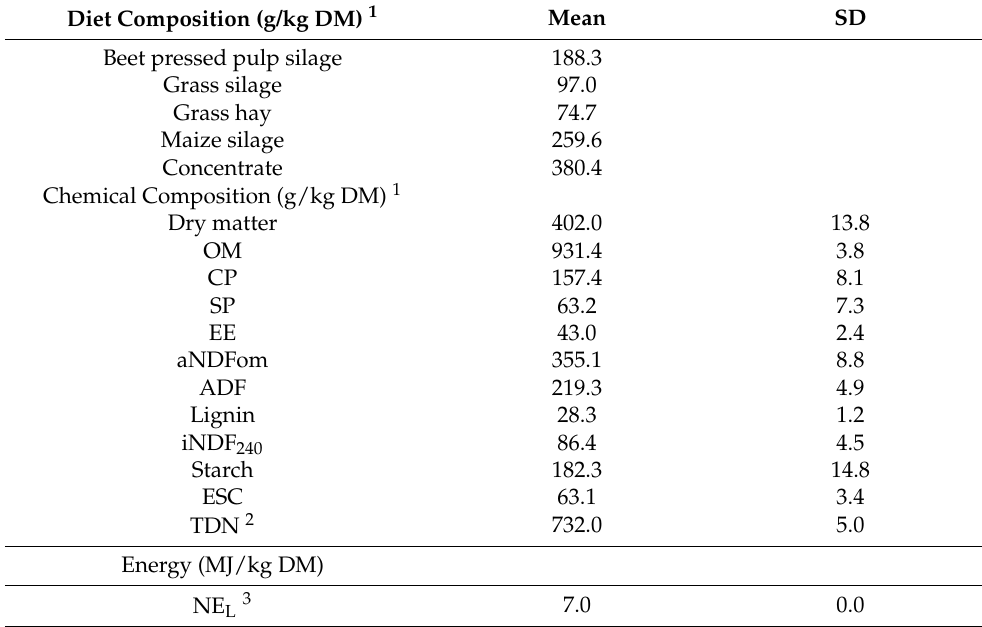
Table 2. Ingredient, chemical composition and energy content of the total mixed